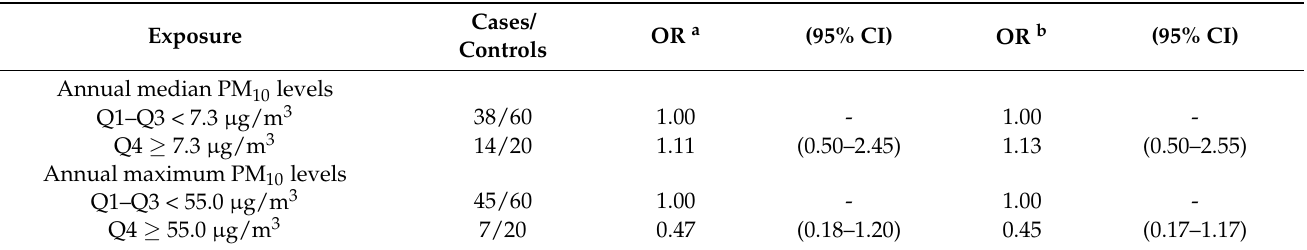
Table 6. Risk of amyotrophic lateral sclerosis according to particulate matter (PM 10 ) exposure comparing the highest and the three lowest quartiles lumped